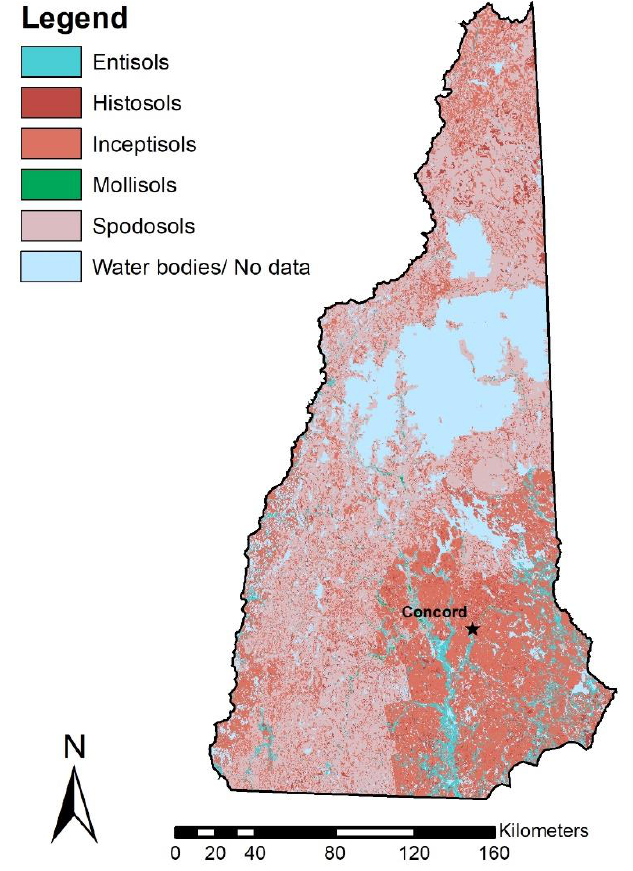
Figure 1. General soil map of New Hampshire (U.S.A.) (Latitude: 42° 42′ N to 45° 18′ N ; longitude: 70° 36′ W to 72° 33′ W) (adapted from [12]).